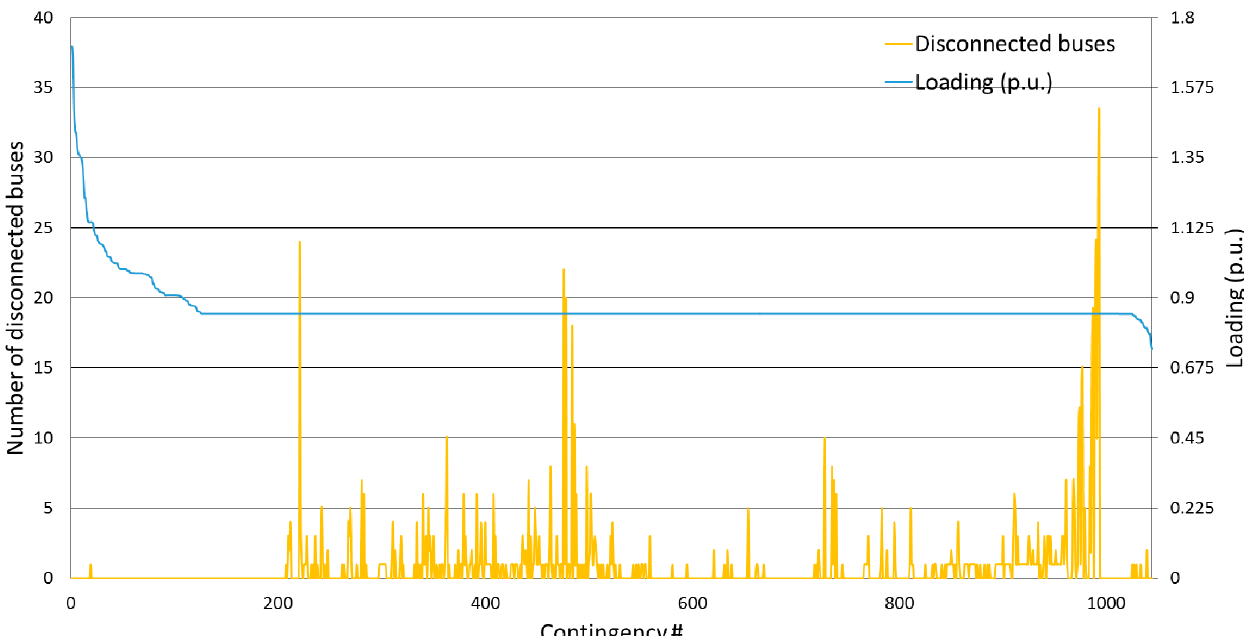
Figure 8. Number of disconnected buses in Case A simulations (in yellow) and maximum branch loading (in blue, the same trend reported in Figure 6).